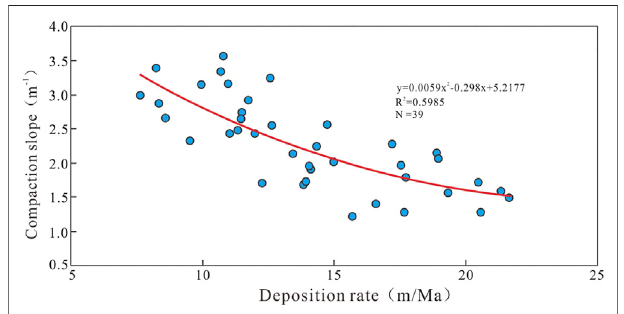
FIGURE 4 | Correlation between compaction slope and deposition rate for normal compaction segments in the Longdong area.